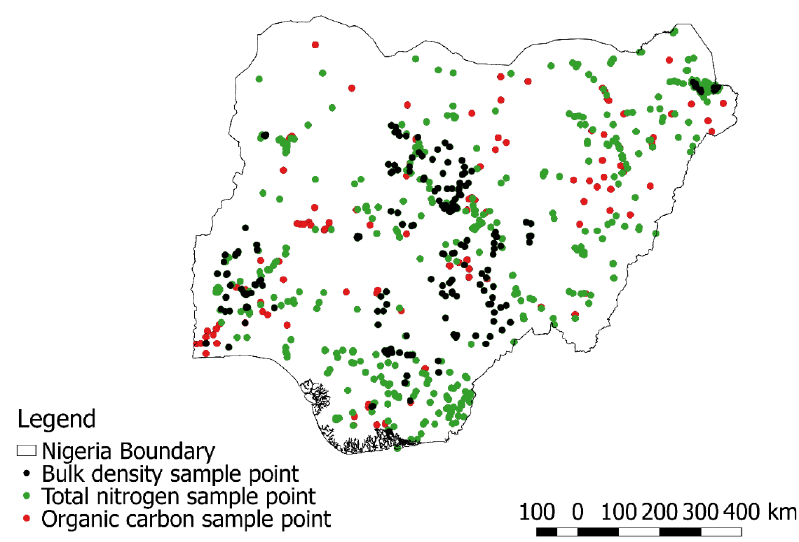
Figure 2. Sample locations of three soil health indicators in the AfSIS database .